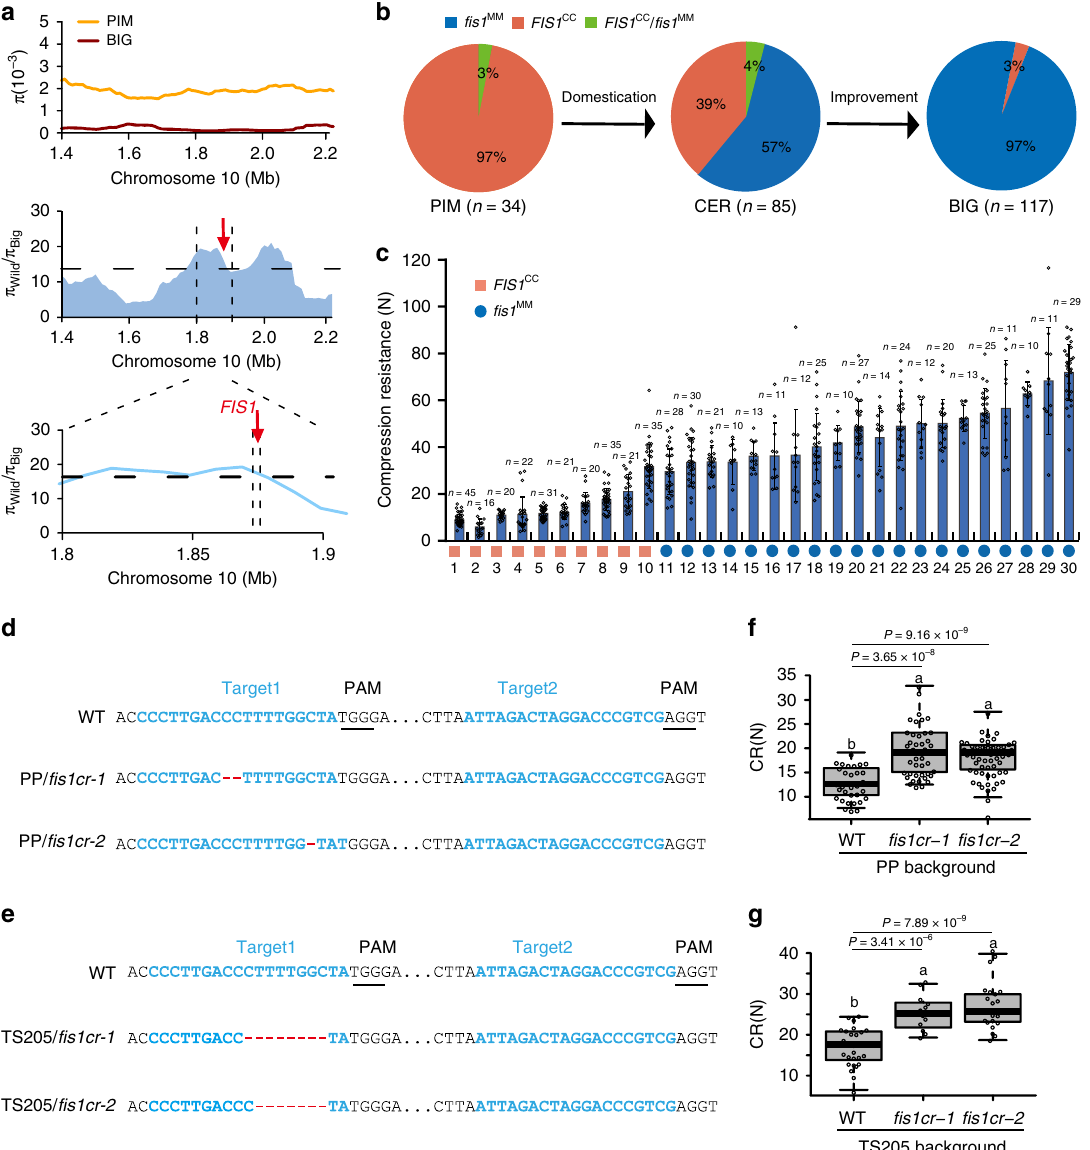
Fig. 5 FIS1 is selected during tomato domestication and is a target for the improvement of fruit fi rmness. a Scan for selection signature surrounding the FIS1 gene. Top: nucleotide diversity ( π ) of wild species (orange line) and big-fruit cultivars (red line). Middle: π ratio of the wild species to big-fruit cultivars (blue region) for a region on chromosome 10. The horizontal dashed lines indicate the genome-wide top 5% ratio cutoff for candidate domestication sweeps. The vertical black dashed lines (bottom) delimit FIS1 . b Frequency distribution of the FIS1 genotype in natural populations including 236 resequenced tomato accessions. PIM: Solanum pimpinellifolium , CER: S. lycopersicum var. cerasiforme , BIG: Big-fruit tomatoes. c CR of 20 cultivated tomatoes with the fi s1 MM allele and 10 cherry tomatoes with the FIS1 CC allele. Error bars, mean ± SD. n = fruit number. d FIS1 mutations generated by CRISPR-Cas9 using two single-guide RNAs in PP. Blue lines indicate the target sites of the guide RNAs. Black lines indicate the protospacer-adjacent motif (PAM). The sequences of PP/ fi s1cr-1/2 mutants are shown. e FIS1 mutations generated by CRISPR/Cas9 using two single-guide RNAs in TS205. The sequences of TS205/ fi s1cr-1/2 mutants are shown. f Box plots of red ripe fruit CR for PP/ fi s1cr-1/2 mutants and PP. n = 31, 42, and 58 fruits. Box edges represent the 0.25 and 0.75 quantiles, and the bold lines indicate median values. Whiskers indicate 1.5 times the interquartile range. Different letters indicate signi fi cant differences according to the Tukey – Kramer test ( P < 0.05). g Box plots of red ripe fruit CR for TS205/ fi s1cr-1/2 mutants and TS205. n = 28, 12, and 23 fruits. Box edges represent the 0.25 and 0.75 quantiles and the bold lines indicate median values. Whiskers indicate 1.5 times the interquartile range. Different letters indicate signi fi cant differences according to the Tukey – Kramer test ( P <